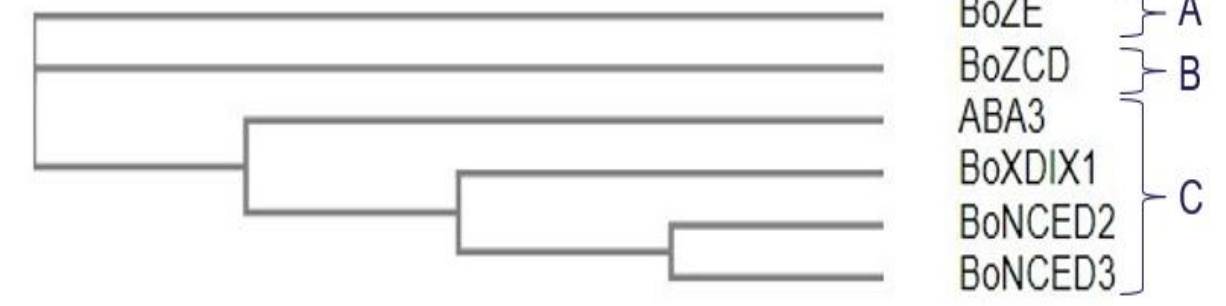
Figure 2. Phylogenetic tree (cladogram) of NCED proteins with other Brassicaceae family members By constructing the phylogenetic tree, the evolutionary relations between the sequences are found. Based on